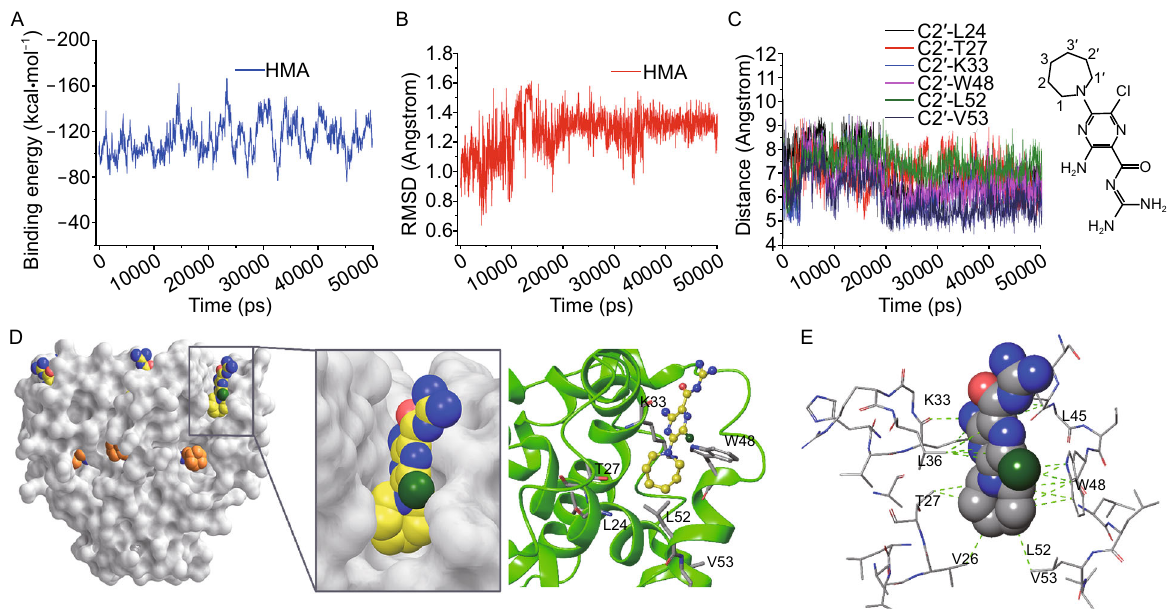
Figure 2. MD simulation re fi nement of HMA binding site . (A) The binding energy between HMA and other surrounding materials in complex system. (B) RMSD value of heavy atoms between the sampled conformations and the starting conformation of HMA during the 50 ns MD production simulation. (C) The distances between the three key carbons of hexamethylene ring of HMA (the three key carbons, C1, C2, and C3, were indicated in HMA structure) and the backbone N atoms of residues L24, K33, W48, L52, and V53 were monitored during the 50 ns MD production simulation. (The monitored distances between carbon and N atoms are approximately equal to the NOEs data plus 2 Å). (D) Comparison between adamantane binding site and HMA binding site of HCV p7 channels. Left panel: The peripheral pockets that wrap around the adamantane cage of rimantadine (orange) and the hexamethylene group of HMA (yellow). Right panel: A representative pocket of HMA binding among six equivalent pockets in the p7 hexamer. (E) The MD simulation result showing the hydrophobic interactions and the polar interactions between HMA and p7